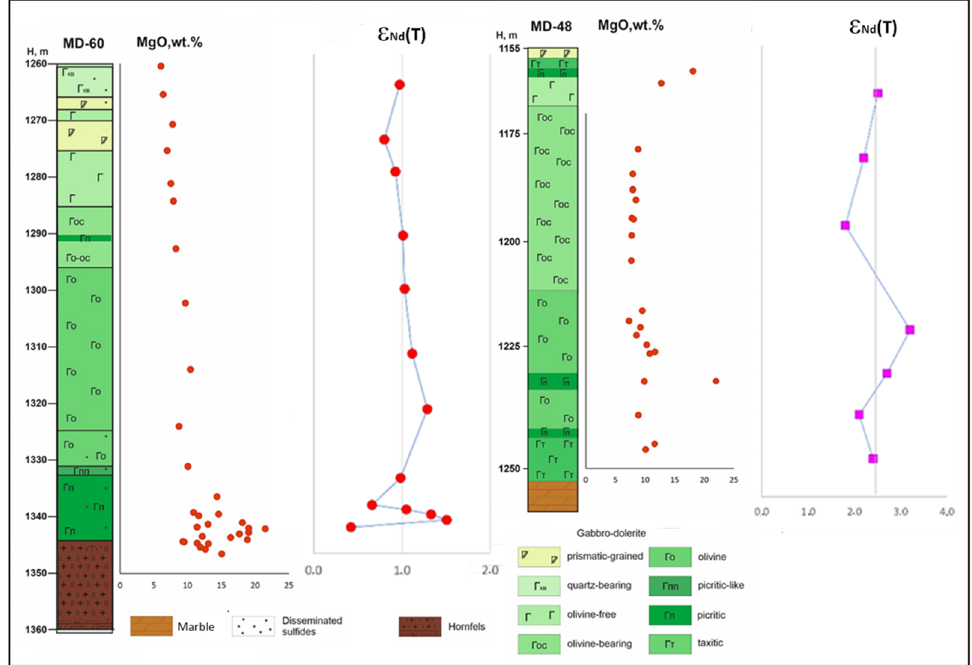
Figure 3. The MgO and Ԑ Nd (T) variations in the MD-60 and MD-48 boreholes. Nd isotopic data for MD-60 are from this work (Table 1) and from [22,23] for MD-48.